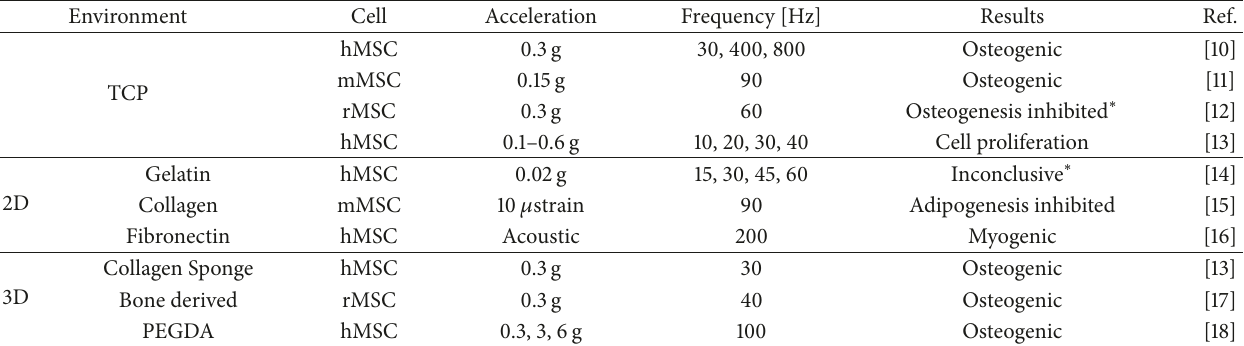
Table 1: Effect of vibration on